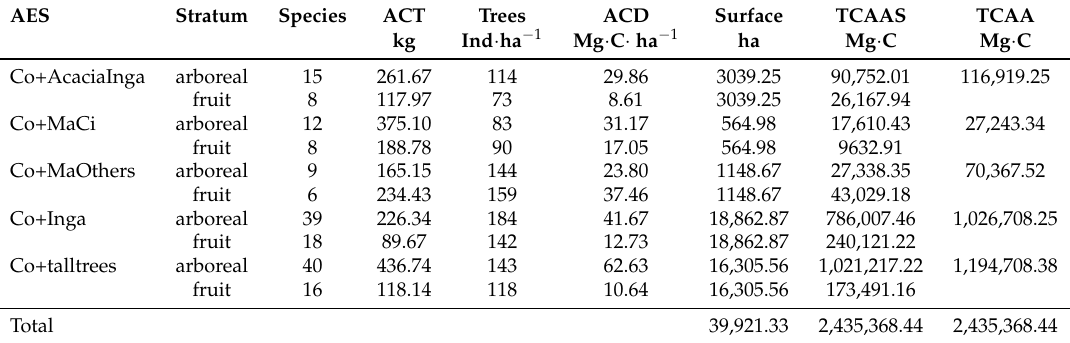
Table 5. Total C stored in the aboveground by type of coffee agroecosystem in the study region Veracruz, México. AES = agroecosystem; ACT = average Carbon by tree; ACD = aboveground carbon density; TCAAS = total aboveground Carbon by agroecosystem and stratum; TCAA = total aboveground Carbon by agroecosystem for the entire region.